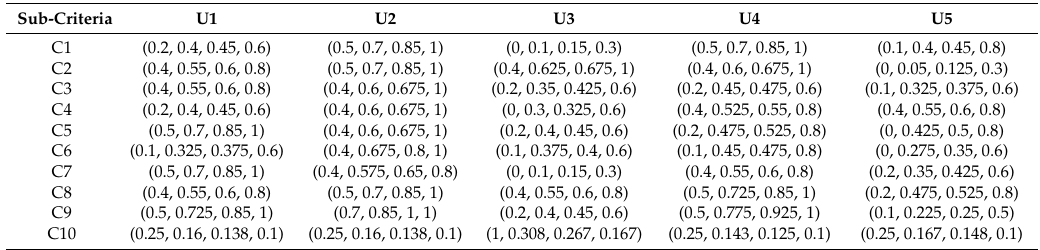
Table 18. Standardization for fuzzy evaluation matrix of five